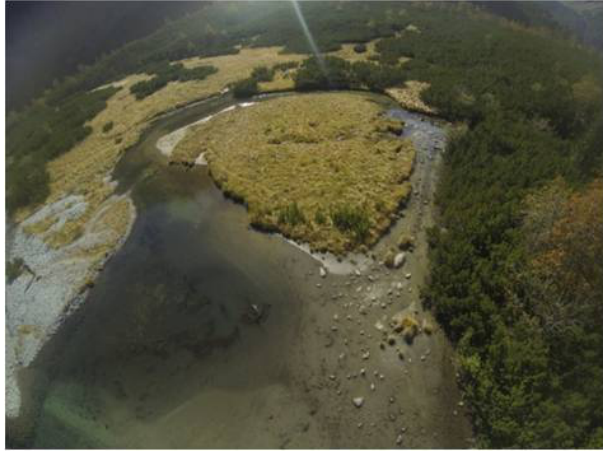
Figure 7. Photo of ˇCierne Javorové pleso alpine lake from an angle, with reflected images of mountains surrounding it.